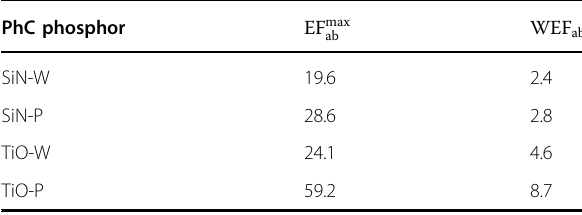
Table 1 The maximum absorption enhancement factors and the weighted absorption enhancement factors calculated for the four PhC phosphor